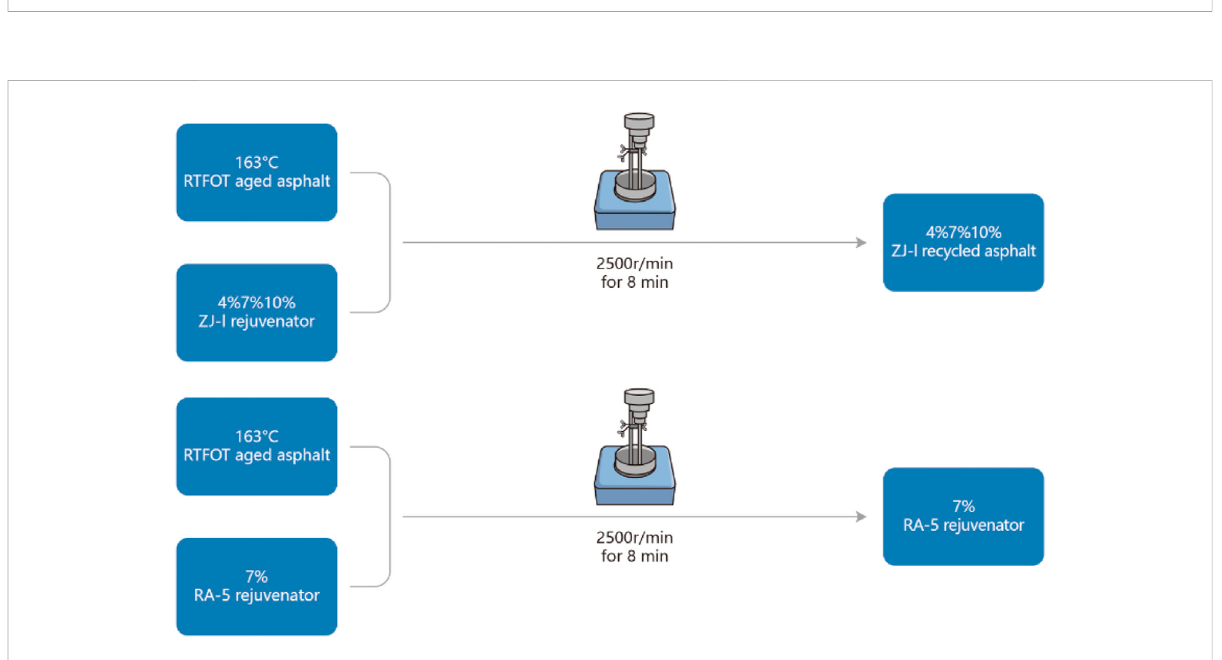
FIGURE 3 Preparation process of recycled